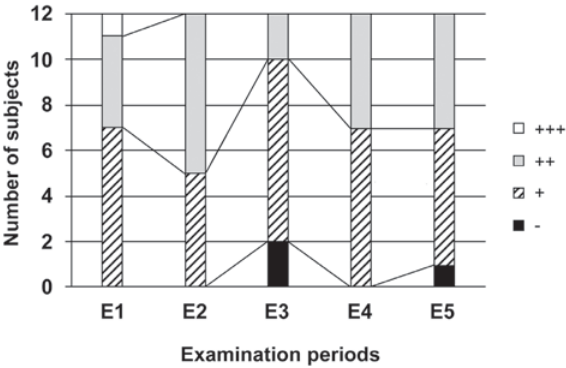
Figure 5- Distribution of the class of Dentocult SM Strip Figure 6- Distribution of the score of CAT21 test in